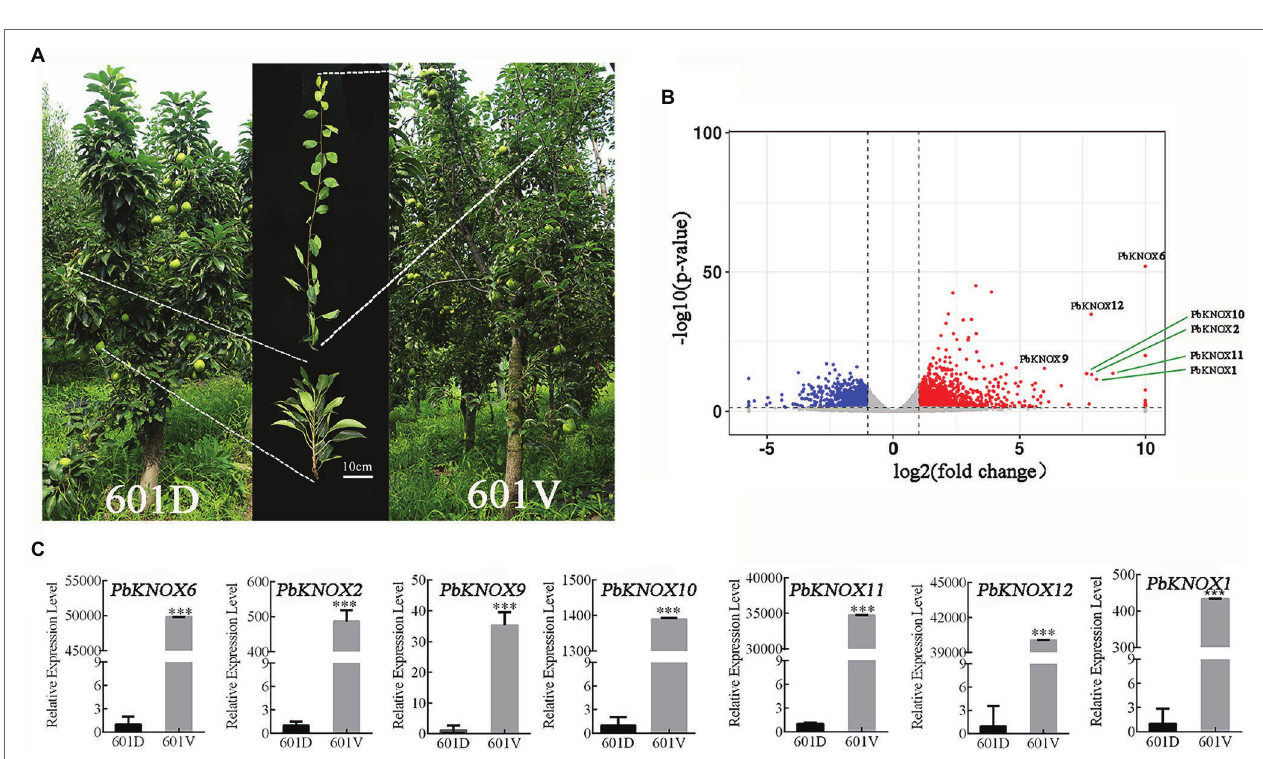
FIGURE 6 | Expression profile of PbKNOX s in “601D” and the new vigorous mutant “601V.” (A) Photographs of “601D” and “601V.” (B) Volcano map of differentially expressed genes in the “601D” and “601V” transcriptome. (C) Expression profile of PbKNOX s in “601D” and “601V” pear. *** p < 0.001 (Student’s t -test). The expression levels of genes in “601D” pear under control conditions were normalized to